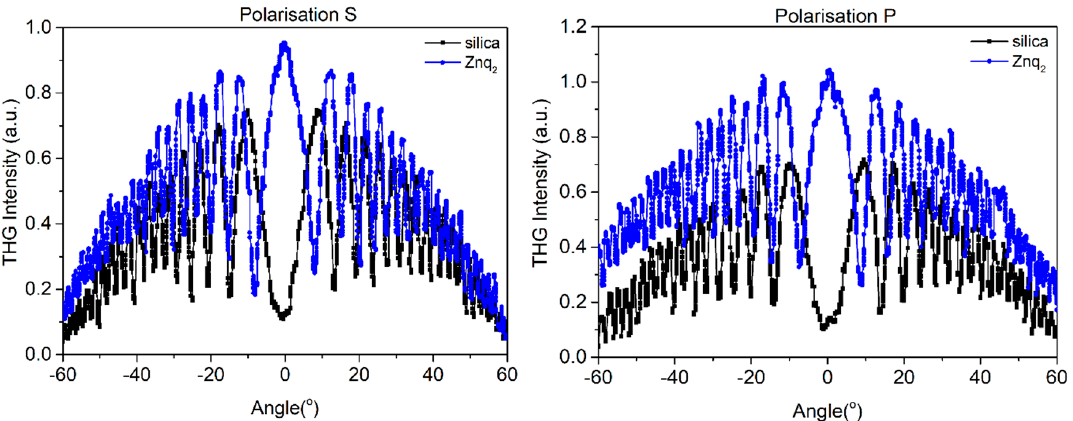
Figure 5. Third harmonic intensity of Znq 2 film and silica as a function of the incident angle for polarization s and p.